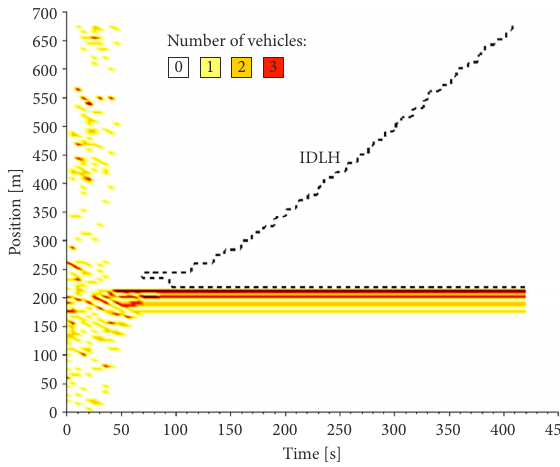
Figure 14. Operator workplace (a) and simulator (b) Figure 15. IDLH area during fire simulation